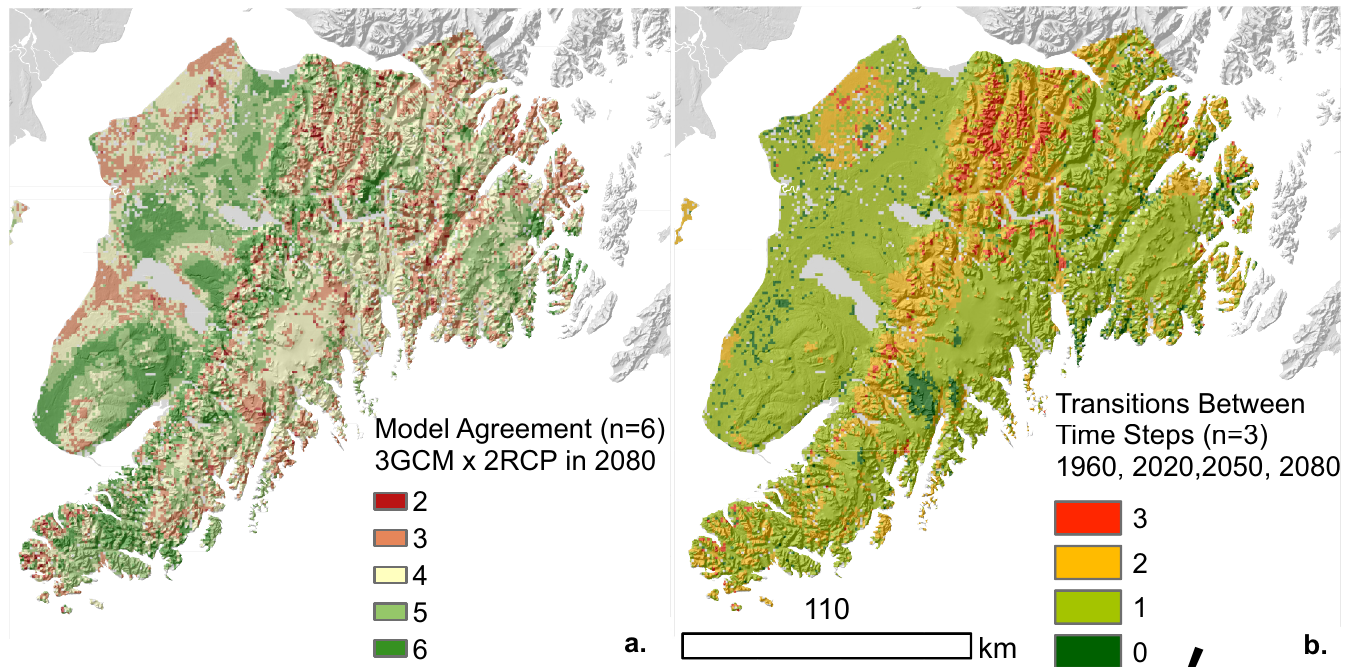
Fig 4. Mapping uncertainty. Maps visualizing uncertainty in future forecasts for the Kenai Peninsula, Alaska. Model agreement represents the number of models representing 3 GCMS and 2 RCPs that converge on the same vegetation community in the 2080s (a). Transitions between time steps represents the number transitions between the baseline, 2020s, 2050s, and 2080s